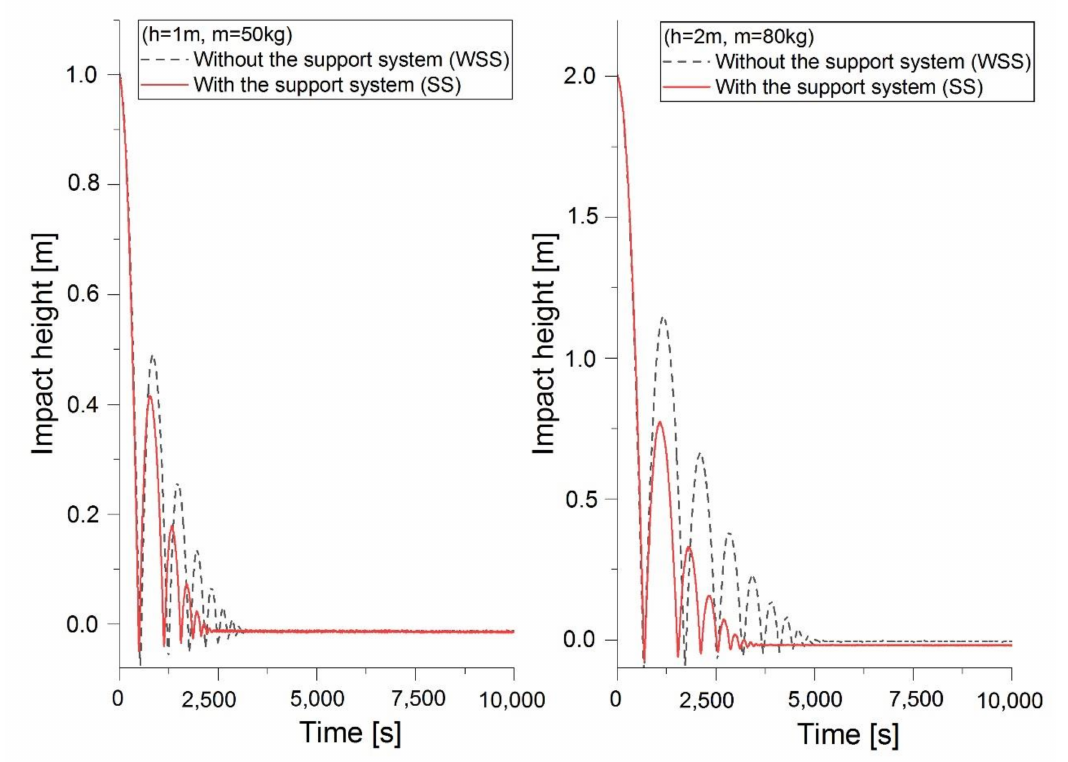
Figure 5. Time course of the drop hammer